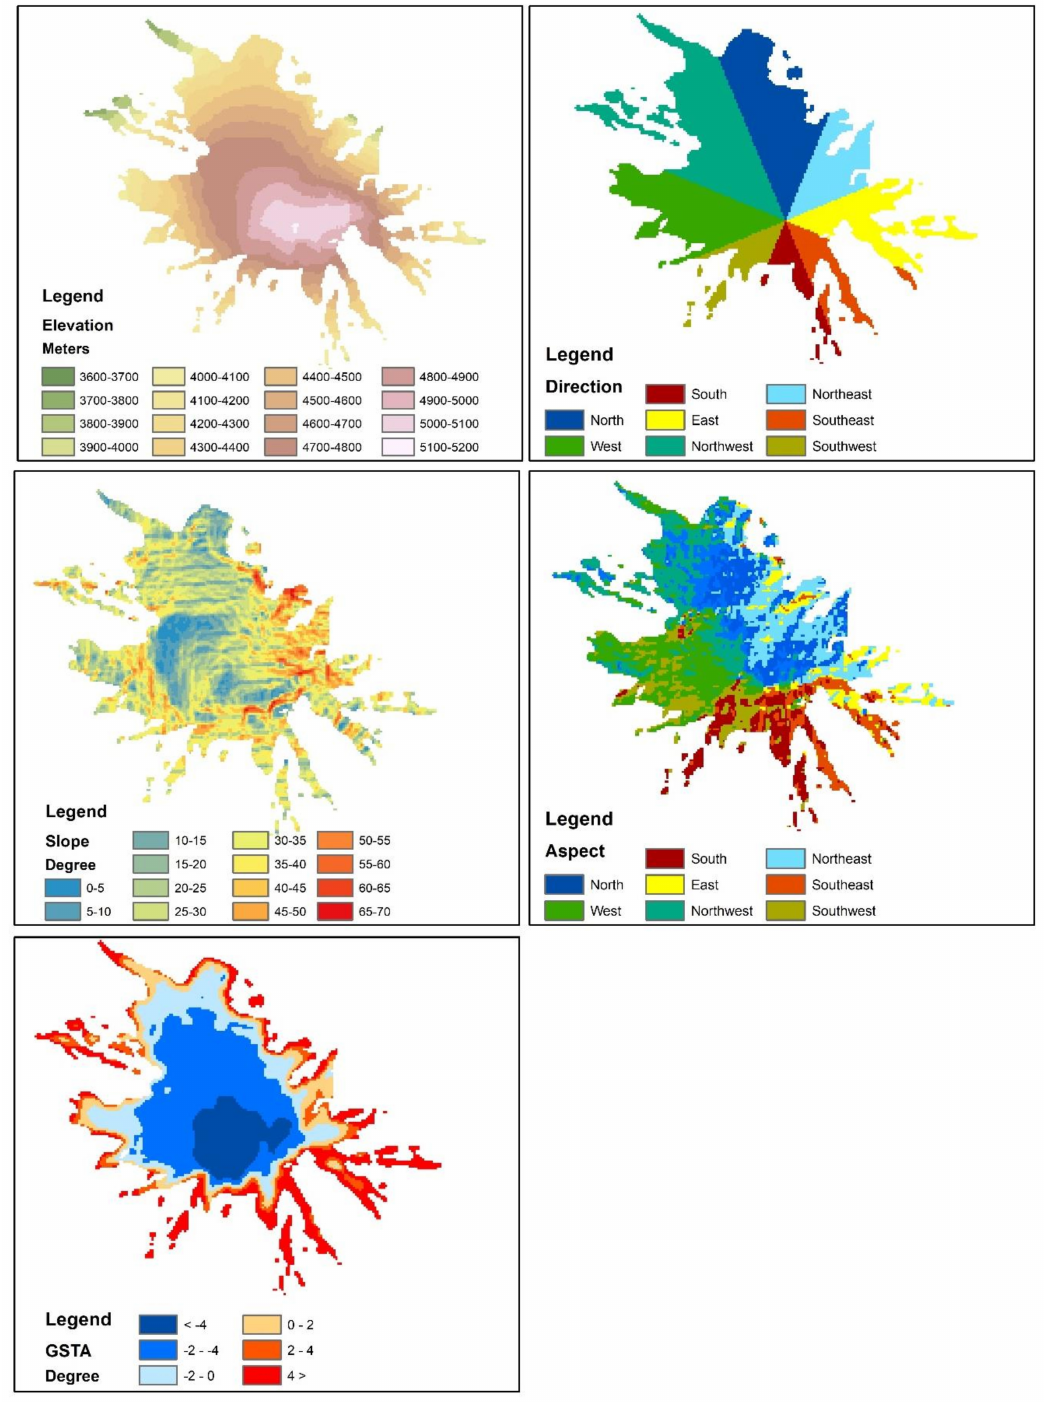
Figure 3. Criteria